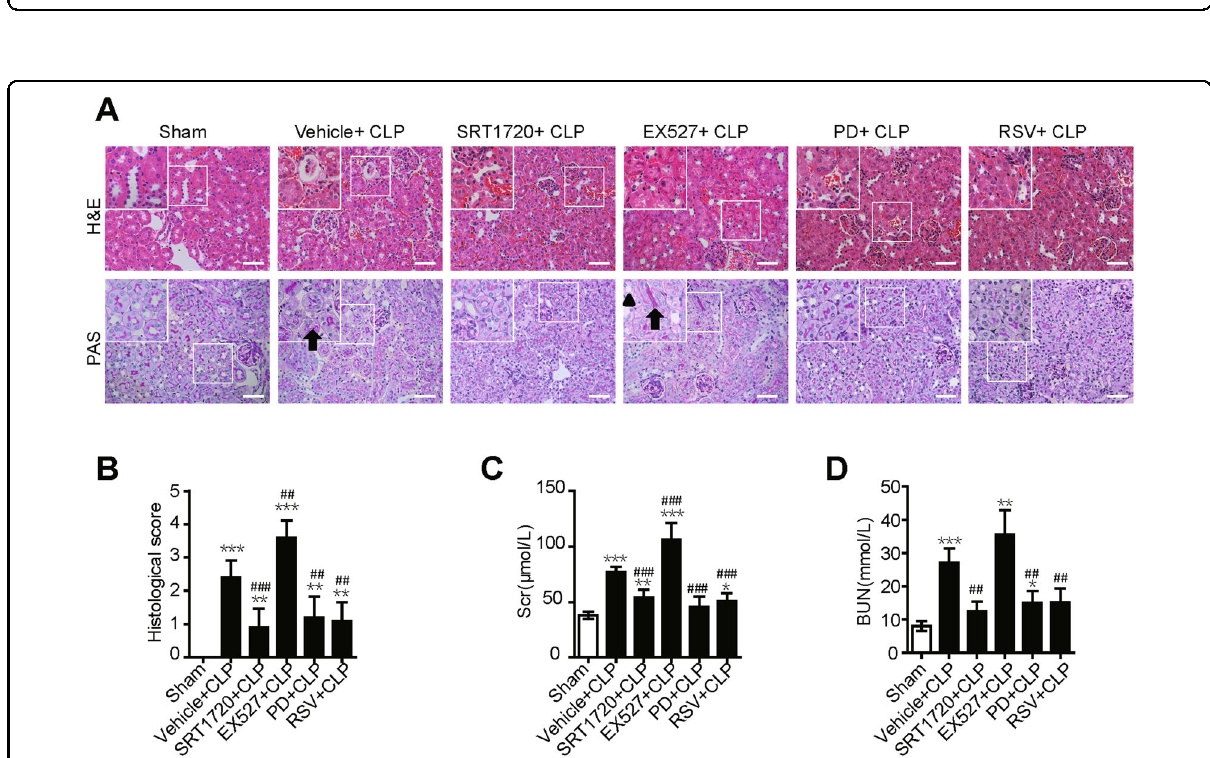
Fig. 7 SIRT1 activation attenuates SAKI. SIRT1 activation by pretreatment with SRT1720, PD, RSV and SIRT1 inhibition pre-treated with EX527 for 2 h, respectively. A Pathological observation of kidney tissue. H&E staining of kidney cortex (upper panel, 200×; inset: 400×; scale bar = 10 μ m) and PAS staining of kidney cortex (lower panel, 200×; inset: 400×; scale bar = 10 μ m). The irregular brush border (arrow) and ectasia of the affected tubules (arrowheads) was observed. B Tubular damage scores were evaluated based on H&E and PAS staining ( n = 10). C Scr levels ( n = 6). D Serum BUN levels ( n = 6). Values shown are the mean ± SD. * p < 0.05, ** p < 0.01 and *** p < 0.001 vs the sham group; ## p < 0.01 and ### p < 0.001 vs the vehicle + CLP group. SAKI sepsis-induced acute kidney injury, CLP caecal ligation and puncture, SIRT1 silent mating-type information regulation 2 homologue- 1, PD polydatin, RSV resveratrol, PAS periodic acid-Schiff staining, H&E haematoxylin-eosin staining, Scr Serum creatinine, BUN urea